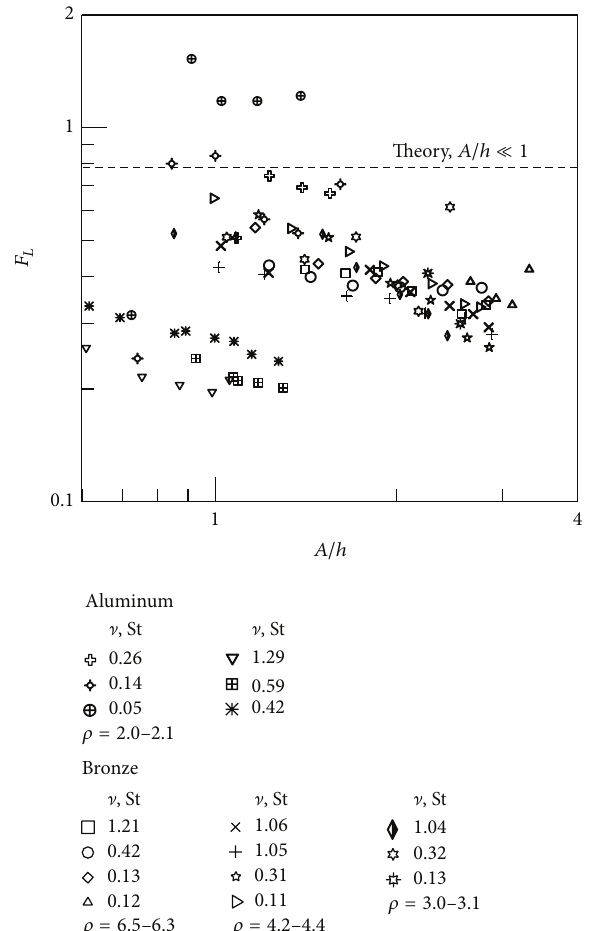
Figure 18: The dependence of the lift force on the amplitude of body